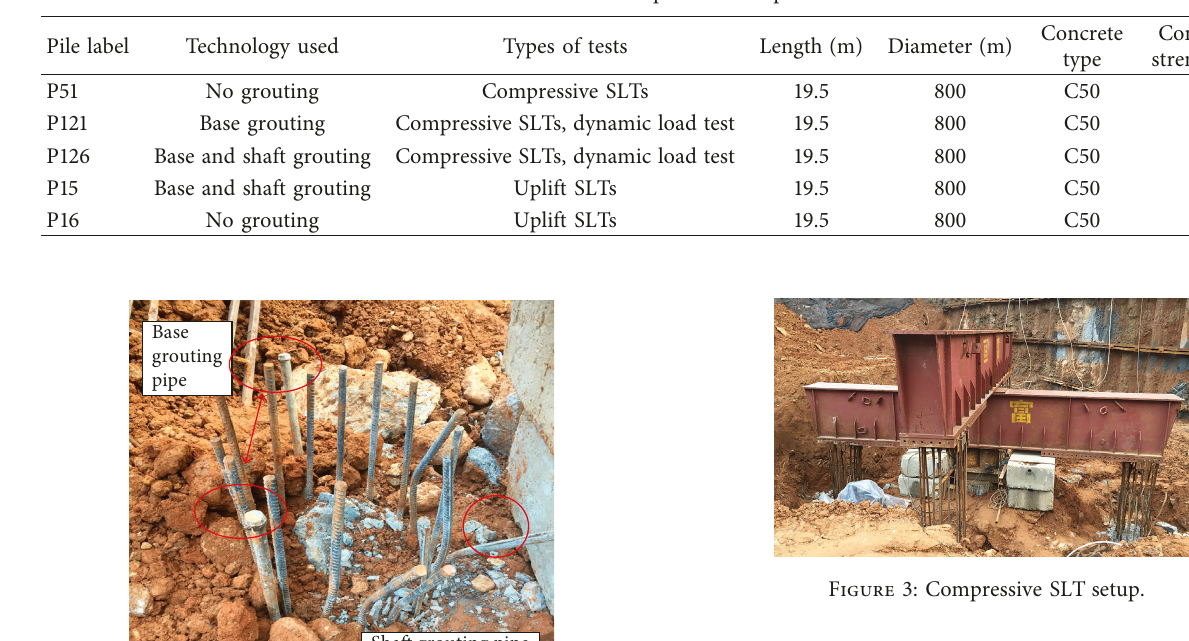
Table 3: Description of test piles.